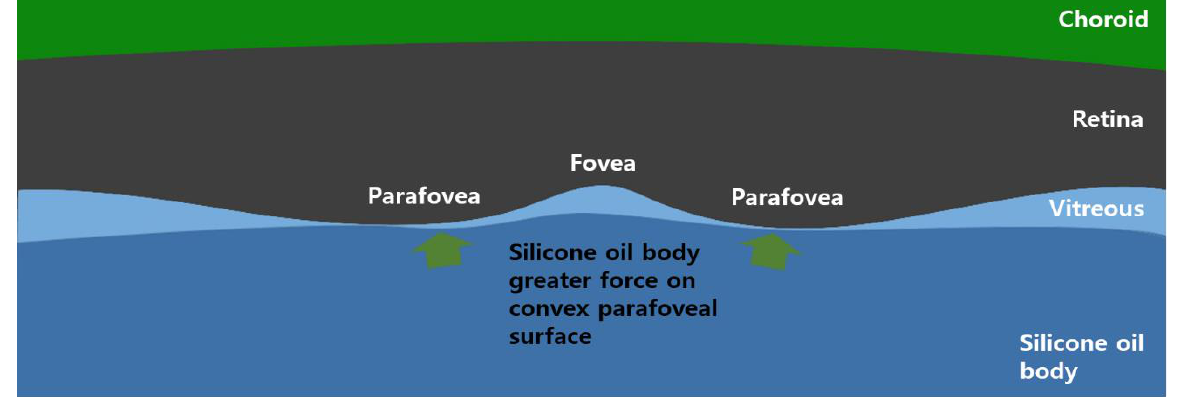
Figure 4. This image illustrates the macular area in the silicone oil tamponade state in the prone position. It can be assumed that a greater force can be applied on the parafoveal surface due to the convex curvature in the prone position.